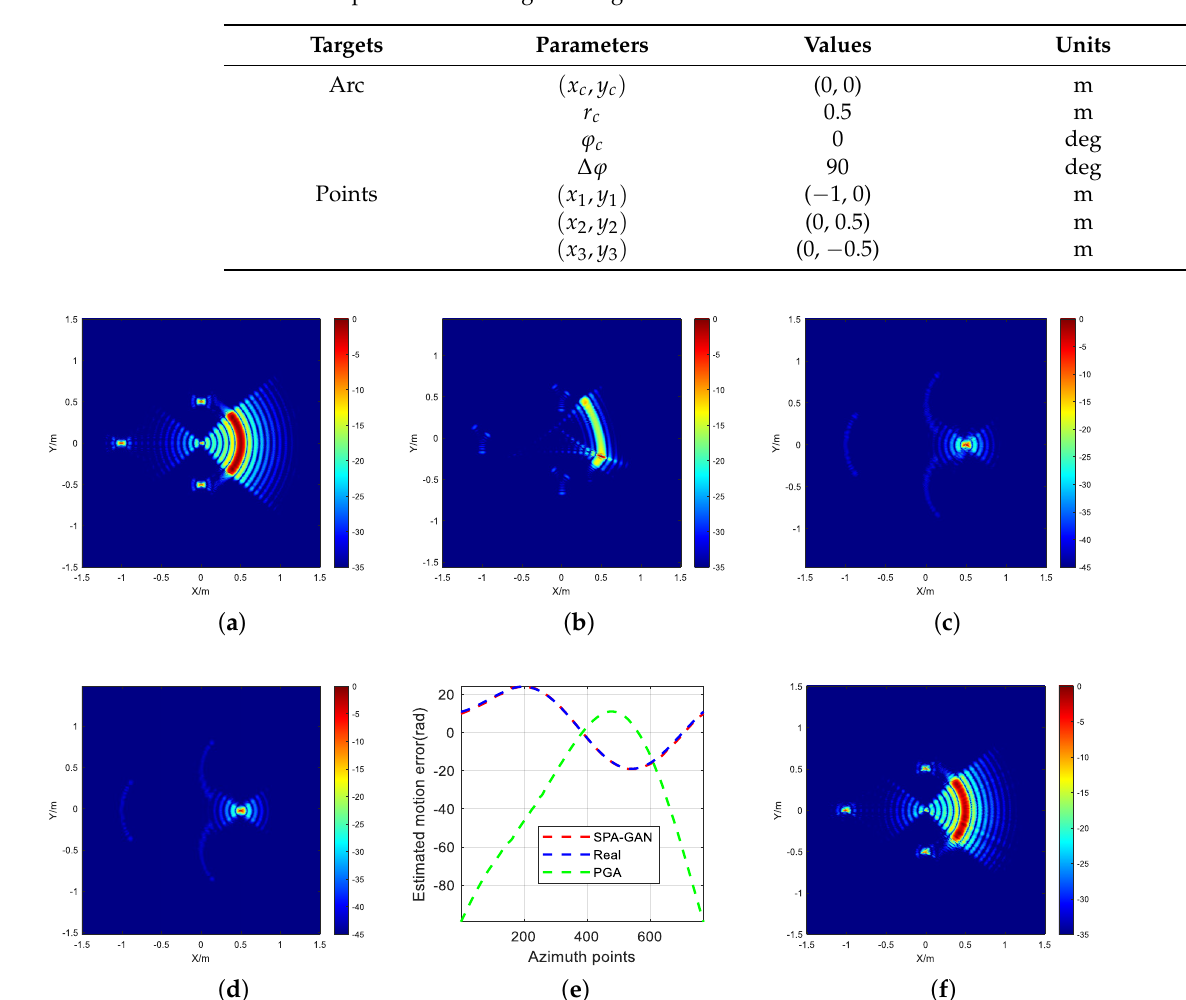
Figure 10. Simulation experiment results of an arc target and three points; ( a ) the BP result with the ideal trajectory; ( b ) the BP result with the real trajectory; ( c ) the PGA resul; ( d ) the MSE result; ( e ) the estimated motion error of the proposed SPA-GAN, PGA and real motion error; ( f ) the proposed SPA-GAN